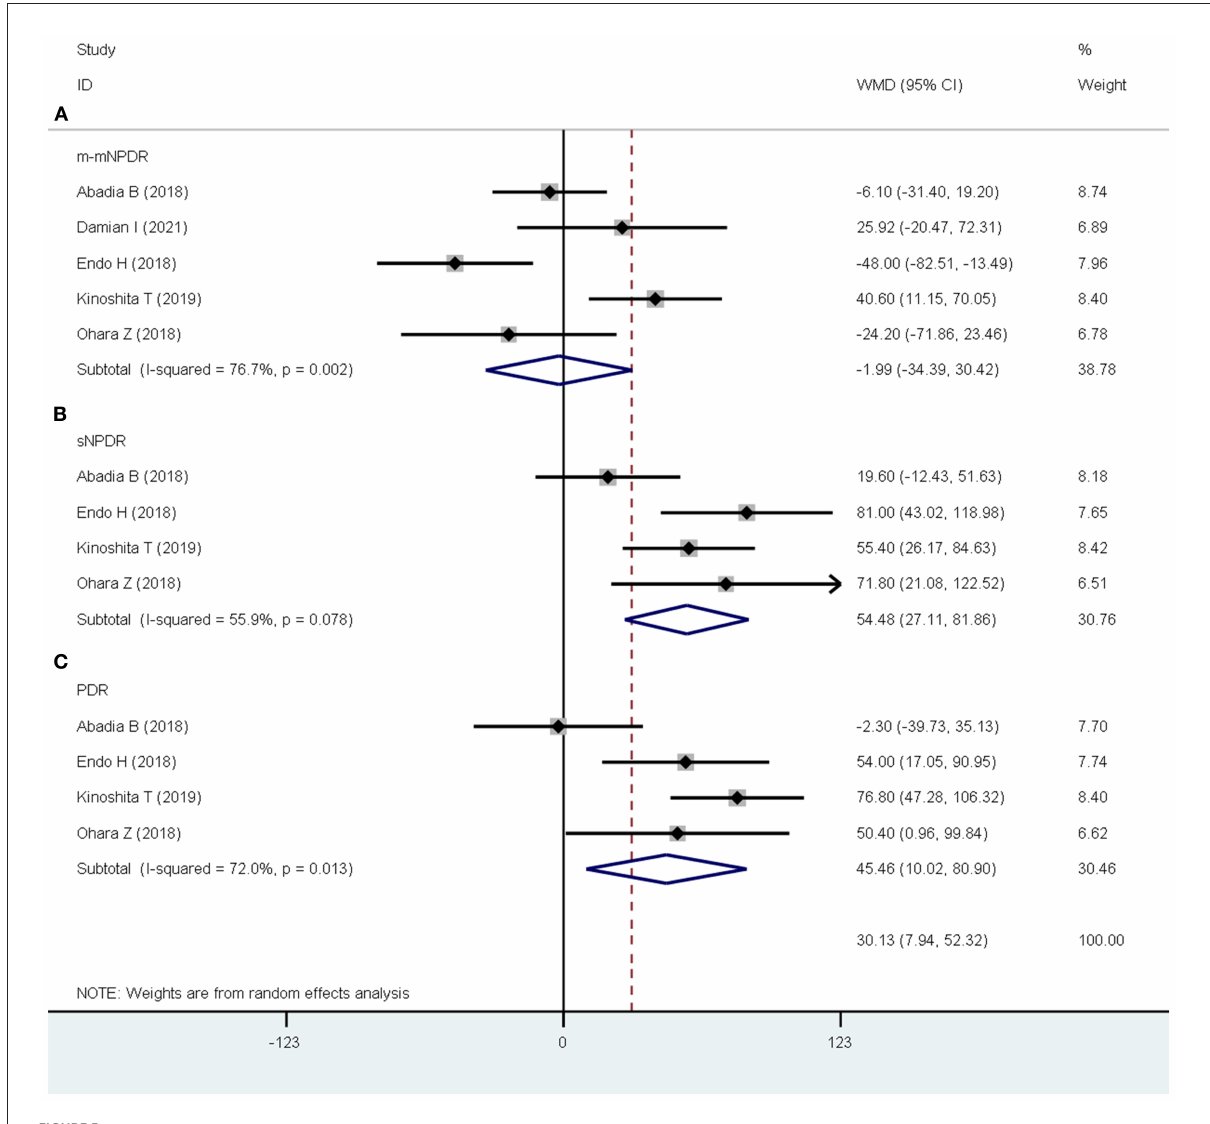
FIGURE5 Subfoveal choroidal thickness (SFCT) in patients with NDR and different DR stages. (A) NDR and m-mNPDR. (B) NDR and sNPDR. (C) NDR and PDR.